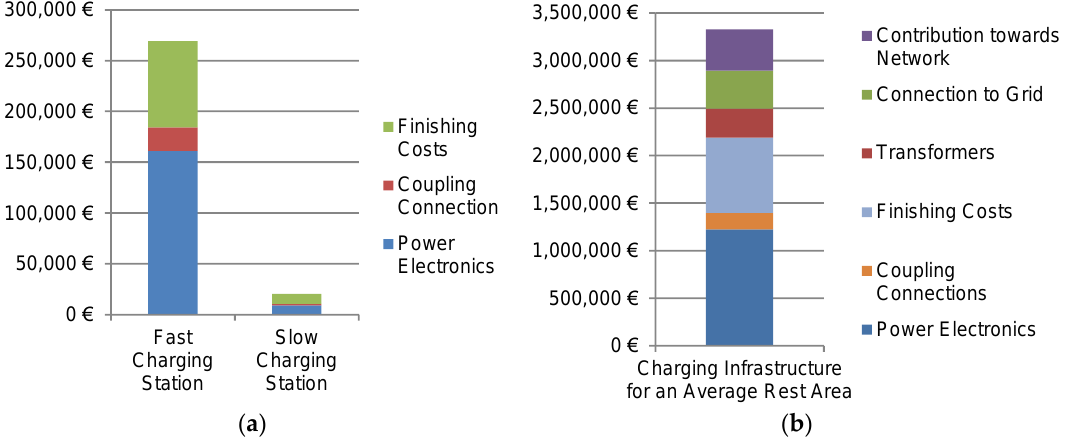
Figure 15. ( a ) Costs composition for a particular charging station; ( b ) Composition of total construction costs for an average charging place equipped with 6 fast and 28 slow charging stations.